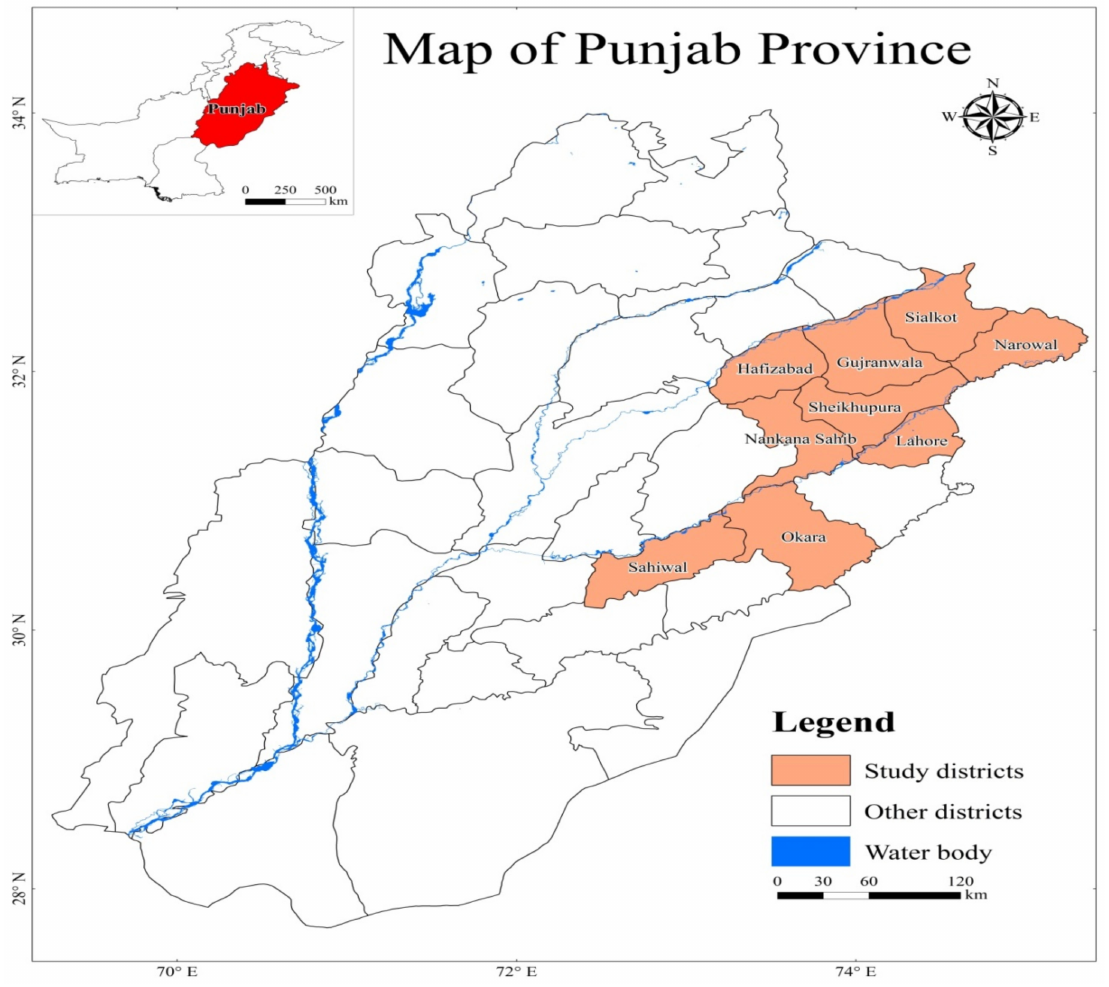
Figure 2. Map of the study